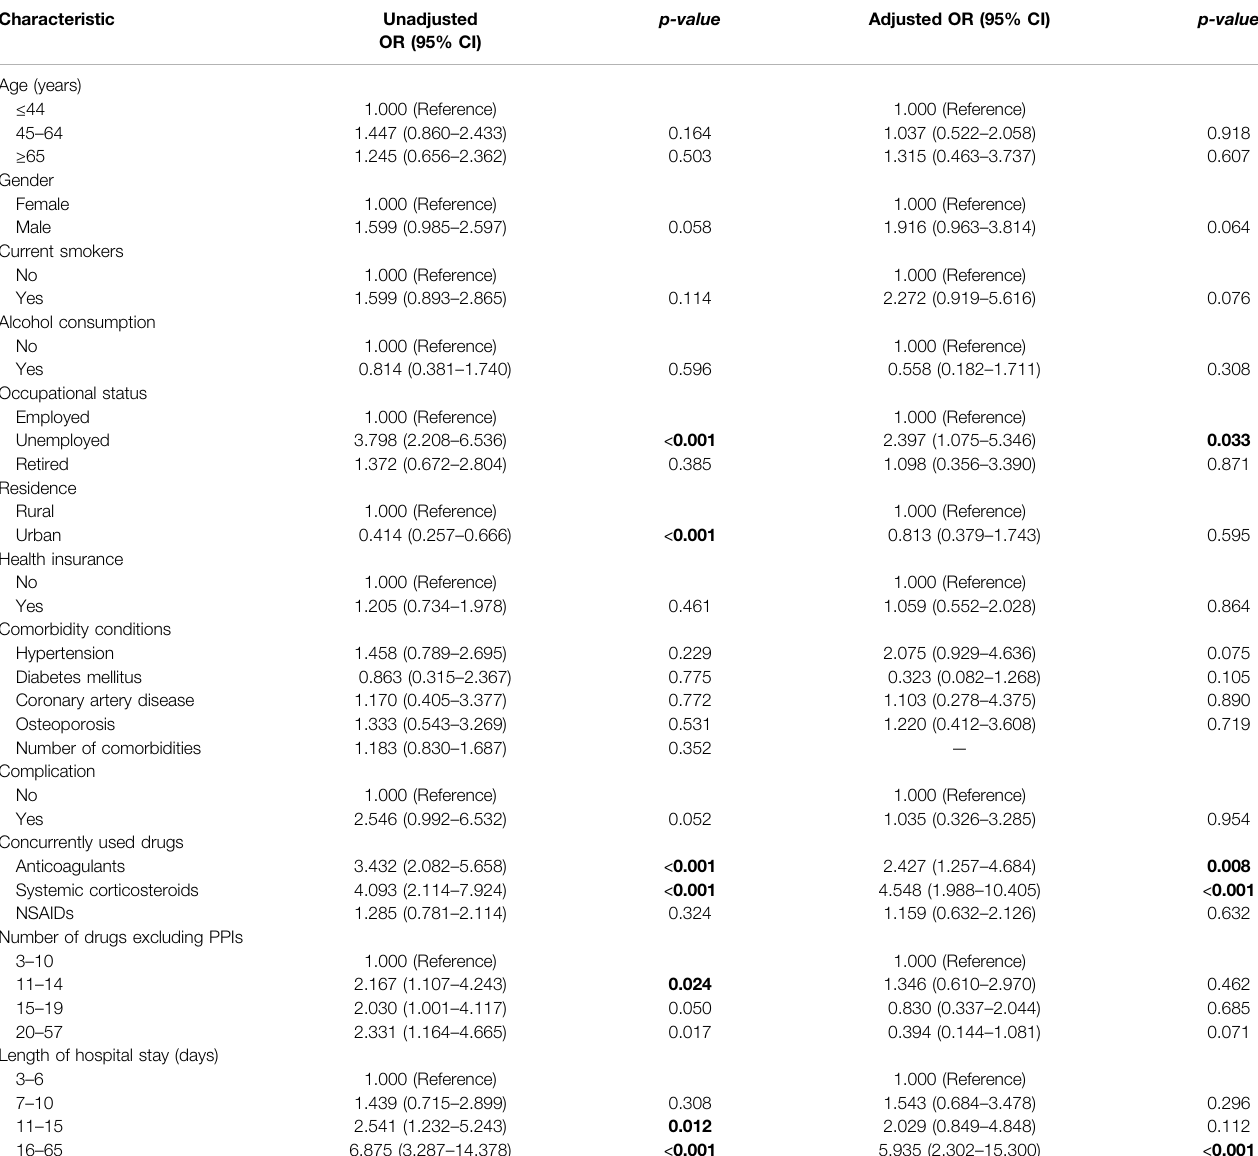
TABLE 8 | Univariate and multivariate logistic regression analysis of factors associated with underprescription of ASMs for SUP.